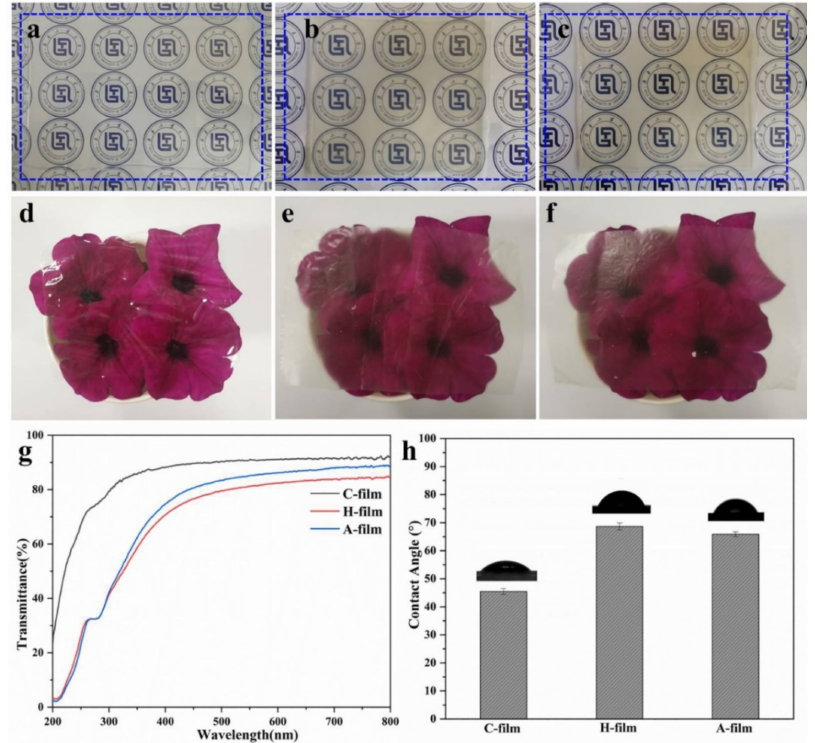
Figure 4. Optical pictures of the regenerated gels (( a ) C-gel; ( b ) Hydrogel; ( c ) Alcogel) and films (( d ) C-film; ( e ) H-film; ( f ) A-film); ( g ) UV-Vis spectra of C-film, H-film and A-film; ( h ) Water contact angles of the C-film, H-film, and